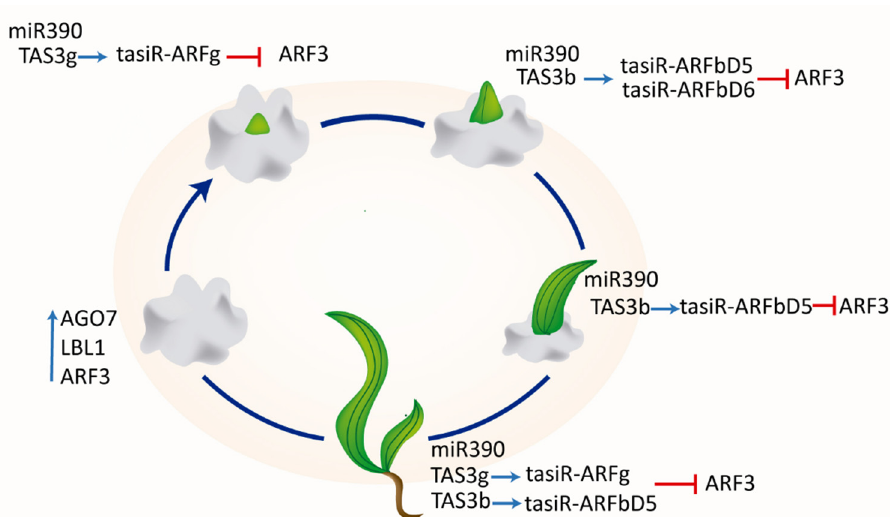
Figure 5. tasiR-ARFs pathway dynamics during maize in vitro plant regeneration. Maize VS-535 regeneration takes place via leaf formation on the callus surface and the established stages display differential accumulation of selected tasiR-ARF to downregulate the transcripts of ARF3-like ZmARF family. At some stages, the elevated tasiRNA levels correspond to decrement of TAS3 precursor and targeted ZmARFs , as well as increase of miR390. At the 1st stage, characterized by regenerative spot formation, there is IC between tasiR-ARFg and ARF3-like ZmARFs . The apical growth of the green spot resembling leaf tip structure at the 2nd stage corresponds to IC between TAS3b -derived tasiRNAs and ZmARF targets. At the 3rd stage, represented by typical leaf development still adhered to the callus, ARF3-like ZmARF transcripts negatively correlate with tasiR-ARFbD5. In regenerated plantlet, there